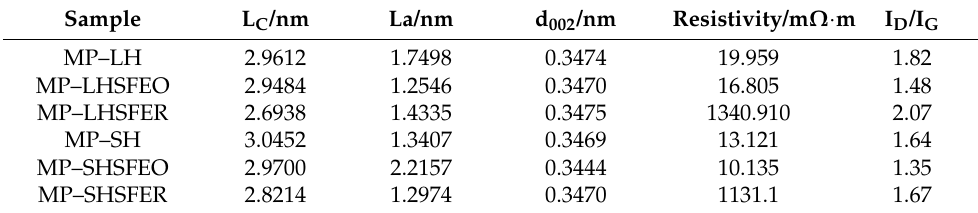
Table 5. Structural performance parameters of several mesophase